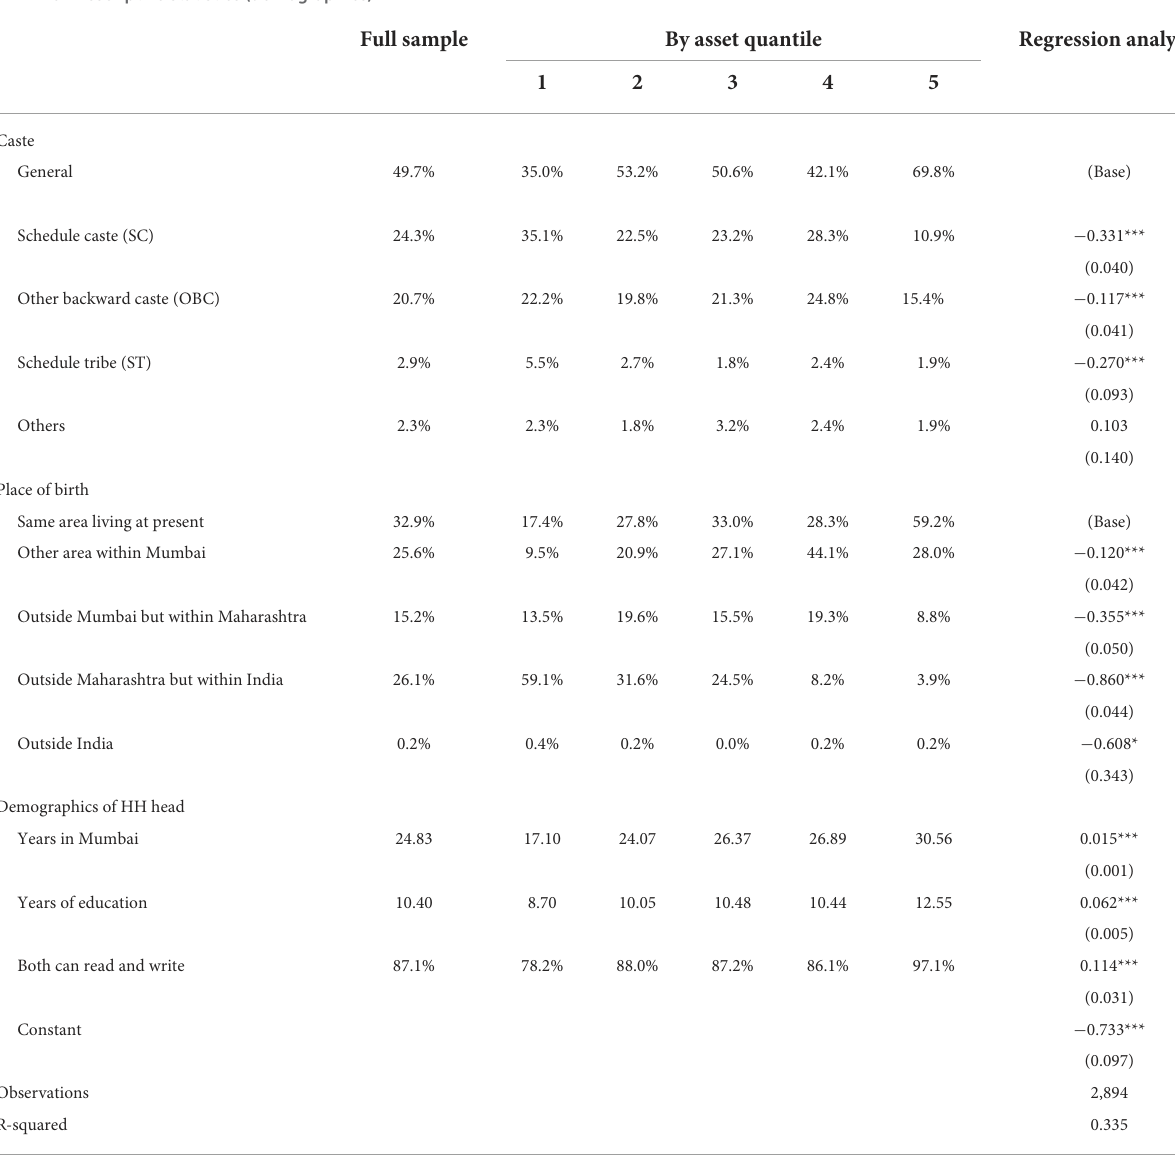
TABLE 3 Descriptive statistics